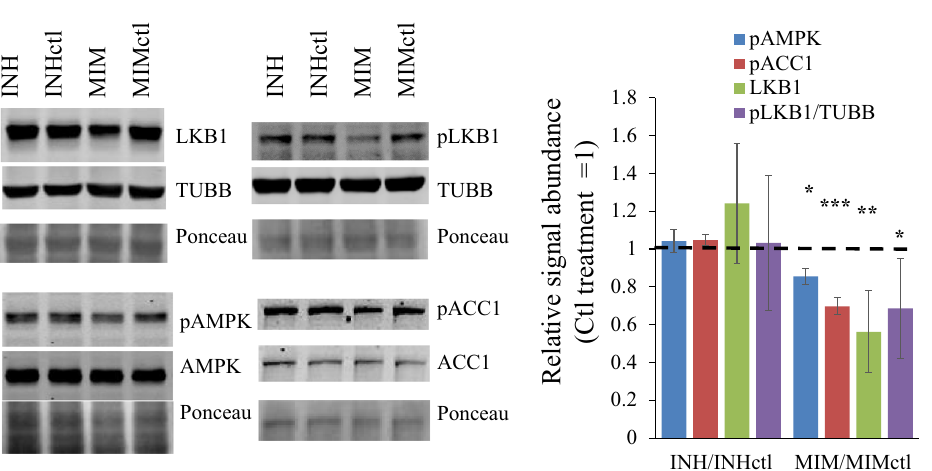
Figure 6. miR1908-5p mimic transfection reduces AMPK activity, LKB1 levels and ACC phosphorylation in HuH-7 cells. HuH-7 cells were treated for 72 h with either mimic inhibitor or miR1908 mimic, and their matching controls. Three distinct gels were probed; Ponceau of the 50 kDa region as loading control is shown. Quantification (average ± S.D from 3 biologics) is expressed relative to unphosphorylated (AMPK, ACC1) or TUBB (LKB1) and normalized internally to the matching control value MIM or INH vs matching ctl: * p < 0.05; ** p < 0.01;*** p <